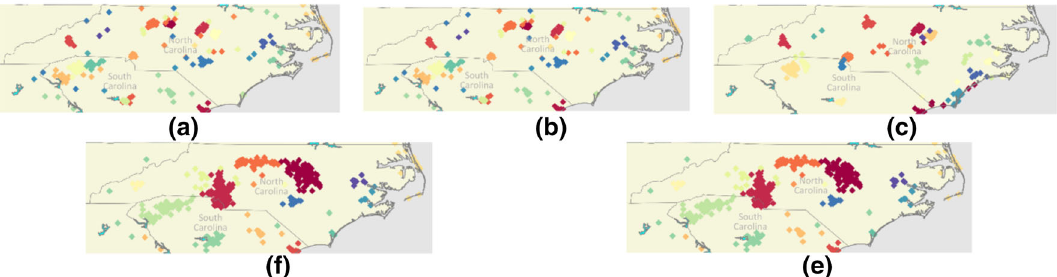
Fig. 5 An example of extracted tweet clusters by a FastText, b GloVe, c Word2vec, d CV and e TFIDF related to Hurricane Florence in North and South Carolina (on each map, tweet clusters are highlighted with different